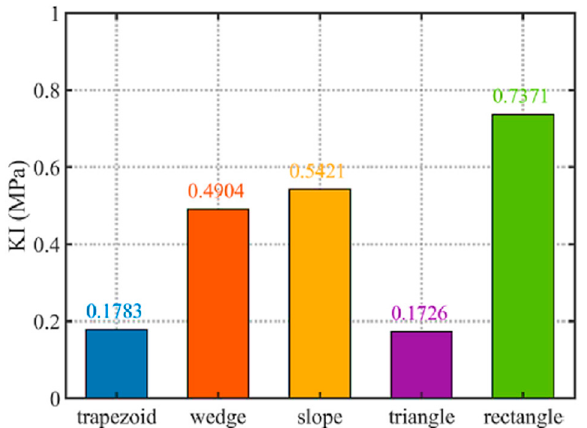
Figure 14. Comparison of knock index for different types of injection rate shapes (Wang et al. [105]).